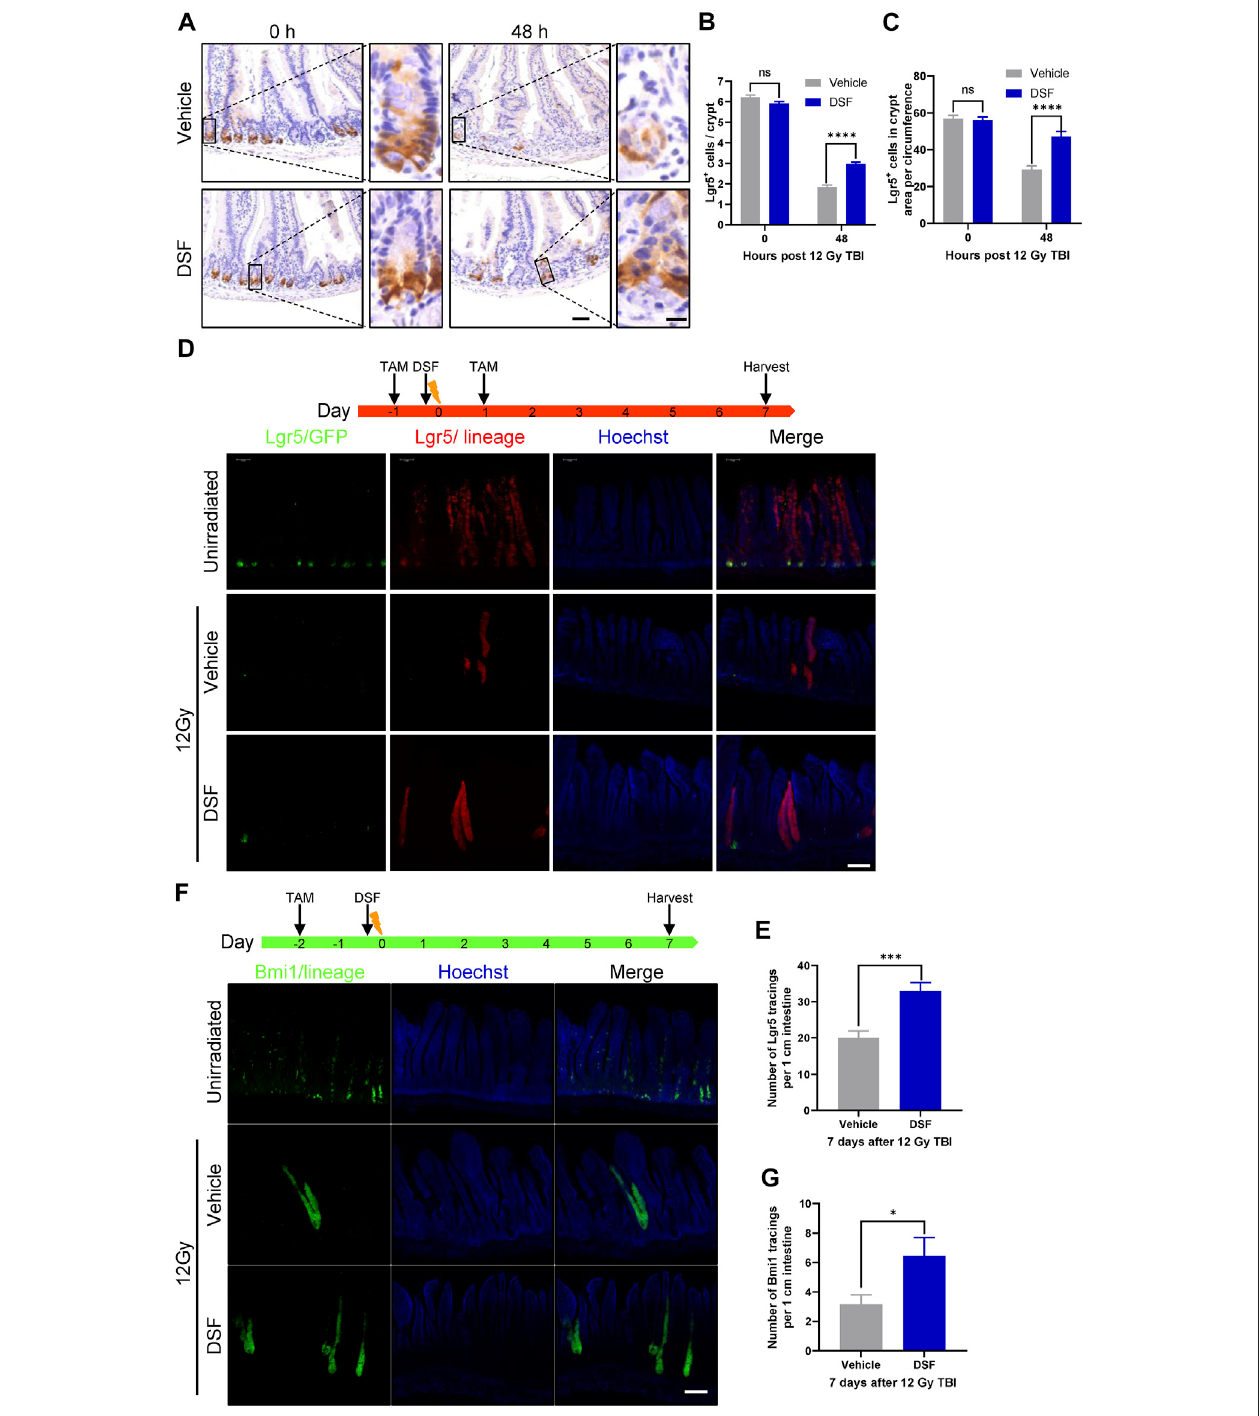
FIGURE 3| DSF protects intestinal stem cells. Mice were intraperitoneal injected with 100 mg/kg DSF or vehicle1 h prior to12 Gy TBI. (A) Representative images of Lgr5 cells by GFP staining in the intestines at 0 and 48 h. Scale bar = 50 μ m (left) and 10 μ m (right). (B) Quantitative analysis of Lgr5-positive cells per crypt in (A) . (C) Quantitative analysis of Lgr5-GFP cells in crypt area per circumference in (A) . (D) Two doses (100 mg/kg) of tamoxifen were injected intraperitoneally into Lgr5-eGFP- IRES-CreERT2; Rosa26-TdTomato mice at the 24 h before and after 12 Gy irradiation. Tissue was harvested on 7 days after 12Gy TBI. Representative confocal images of Lgr5 lineage regenerative response in the jejunum. Scale bar = 200 μ m. (E) Quantitative analysis of Lgr5 tracings per 1 cm intestine in (D) . (F) Bmi1-CreER; Rosa26-YFP mice were intraperitoneal injected with 200 mg/kg tamoxifen at 0 and 48 h before 12 Gy irradiation. Tissue was harvested on 7 days after 12Gy TBI. Representative confocal images of Bmi1lineage regenerative responsein the jejunum. Scale bar =200 μ m. (G) Quantitative analysisof Bmi1tracingsper 1 cm intestine in (F) . Values are means ± SEM; n = 3-5 mice in each group. * p < 0.05, *** p < 0.001, **** p < 0.0001, vehicle versus DSF treatment, by unpaired, two-tailed Student ’ s t-test. TAM,